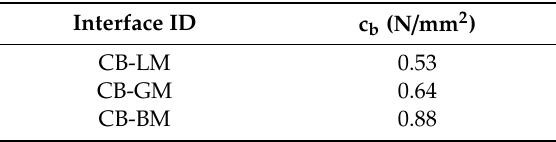
Table 9. Estimated interface bond cohesion.